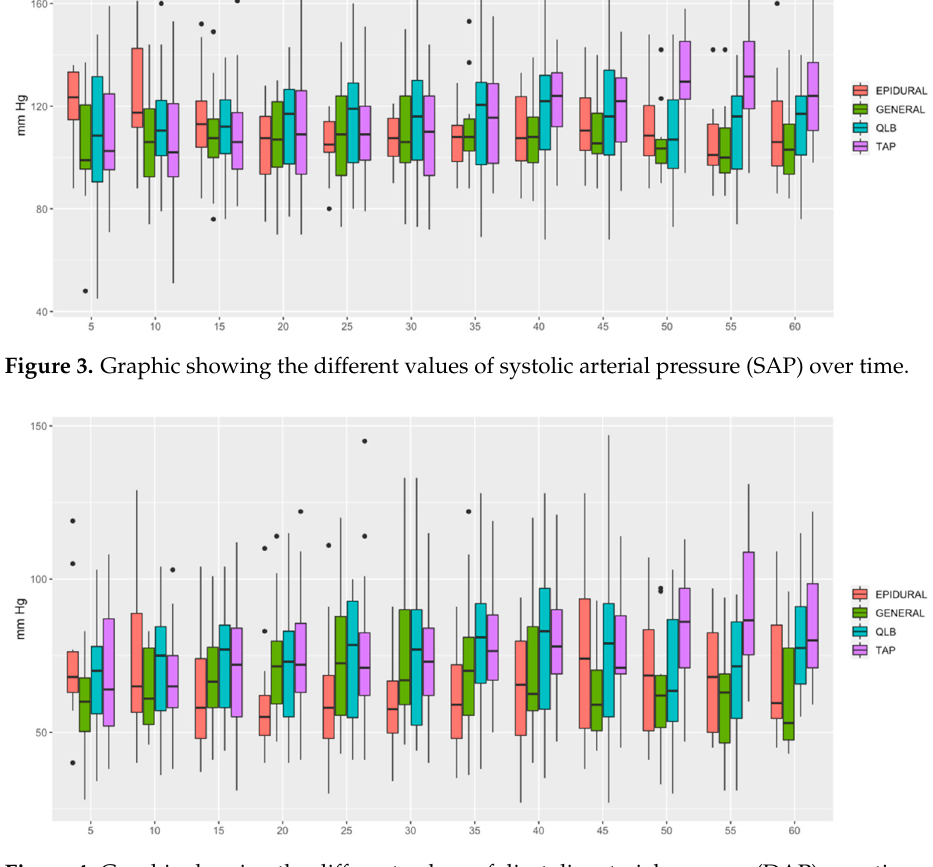
were found among the groups, although the total number of complications was very low. No com-